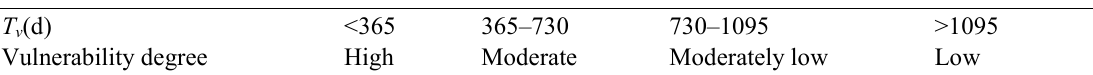
Table 2 Vulnerability degree